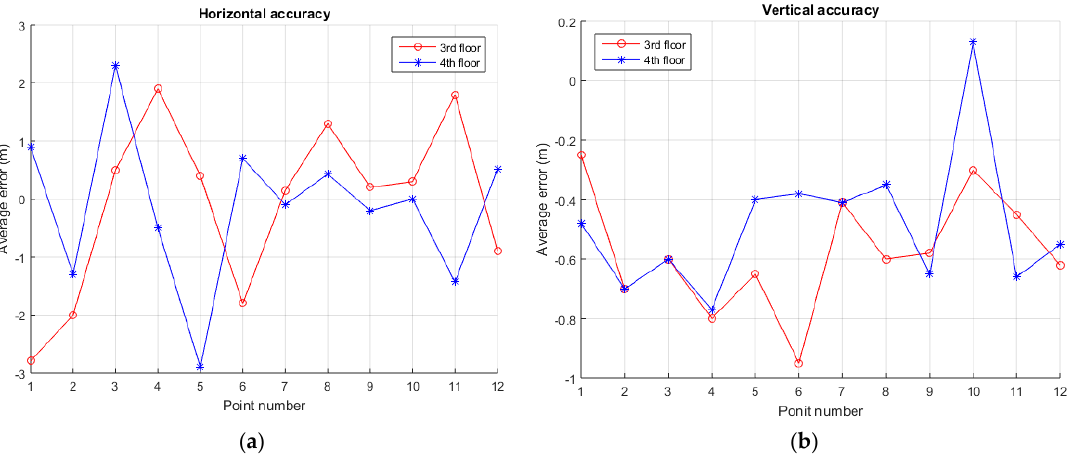
Figure 18. The positioning accuracy of MDBBS: ( a ) horizontal positioning results and ( b ) vertical positioning results.